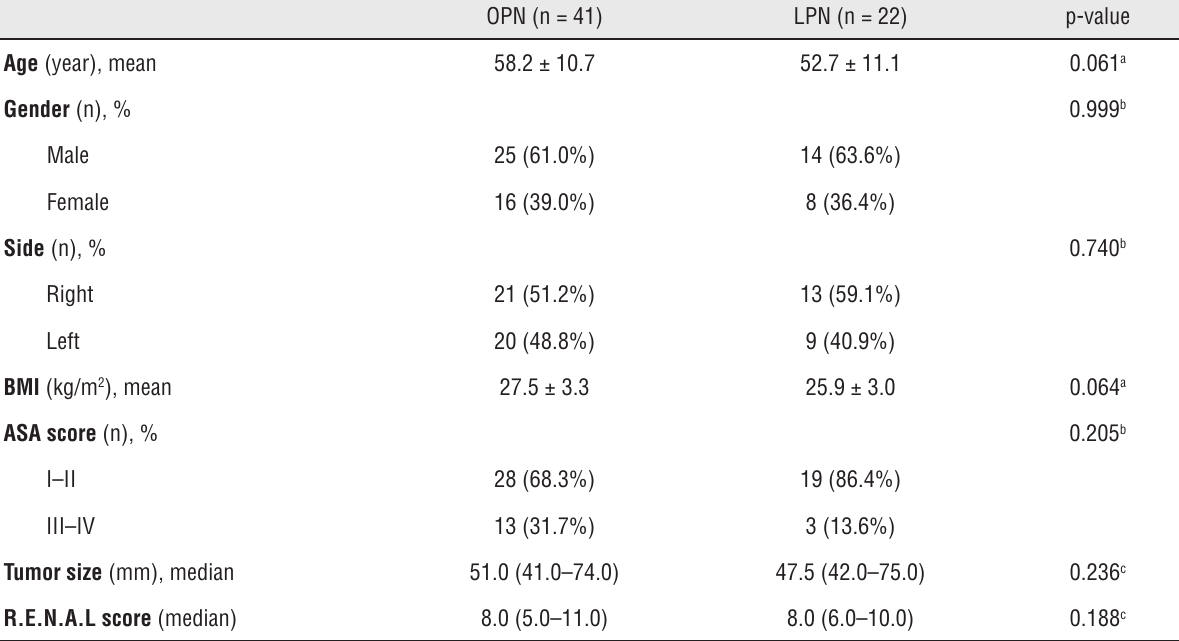
Table 1 - Preoperative characteristics of patients and tumors according to surgical procedures.